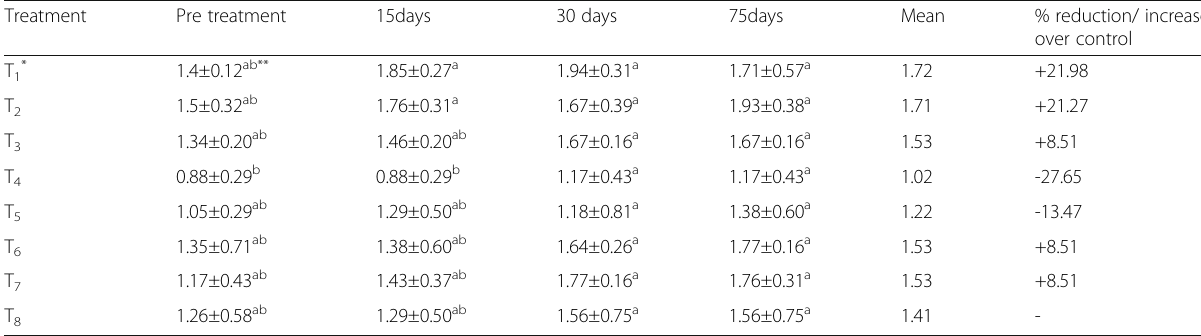
Table 3 Effect of insecticides on collembolan population (per 500 g of soil) at different intervals Treatment Pre